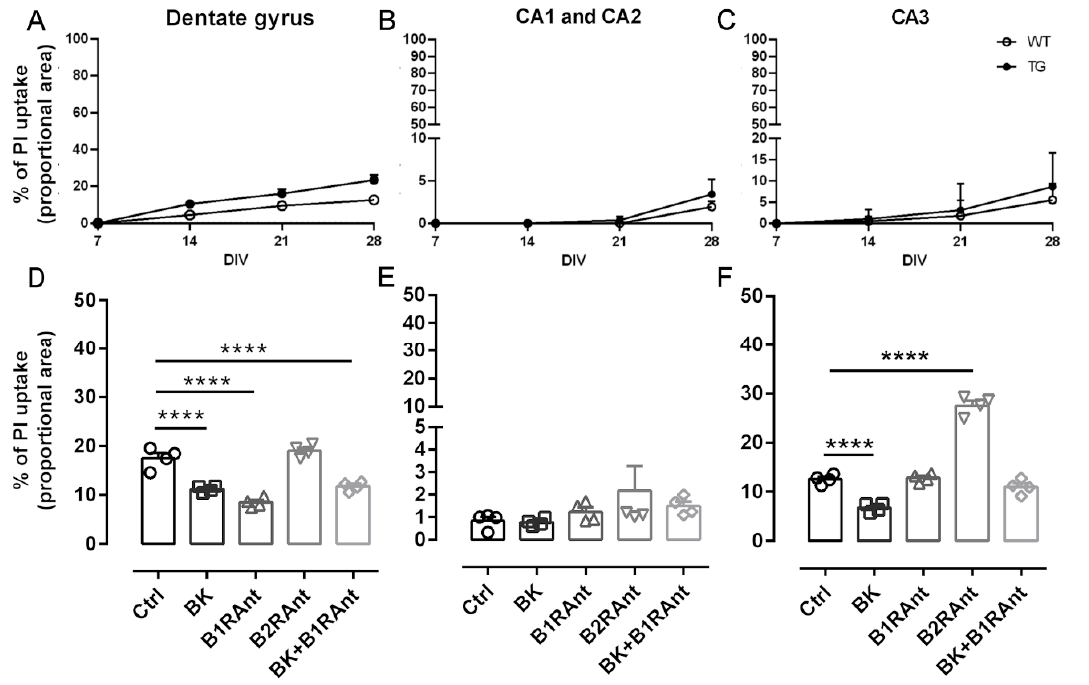
Figure 5. Hippocampal slices of WT and TG animals remained viable over four weeks, and the B2 receptor preserved different areas of the hippocampus of TG animals from cell death. ( A – C ) Percentage of cell death along 28 DIV of six hippocampal slices of three 12-month-old wild-type and TG mice. DIV—days in vitro. ( D – F ) Percentage of cell death in hippocampal slices of 12-month-old TG animals treated with 300 pM BK, 200 pM B1R antagonist ([des-Arg 10 ]-HOE 140), or 300 pM B2R antagonist (Bradyzide) for 20 days (20 DIV). After 20 days, the slices were stained with 1 µg/mL of propidium iodide; images were taken with a Zoe fluorescence microscope and analyzed with ImageJ software. **** p < 0.0001. Data were analyzed with one-way ANOVA followed by Dunnett’s multiple comparison test. Technical quadruplicate of biological samples of four animals were used for each treatment.